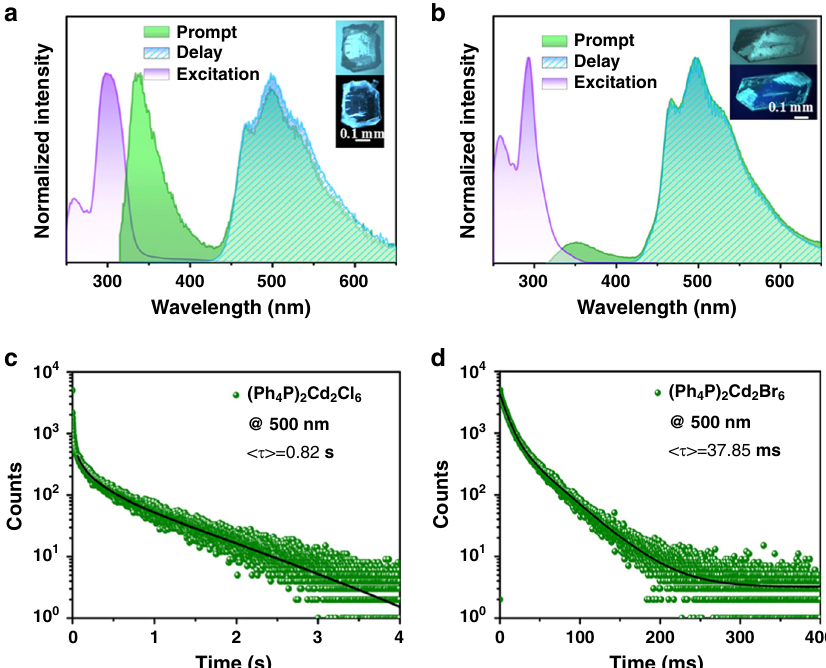
Fig. 2 Luminescence performance of (Ph 4 P) 2 Cd 2 X 6 . Excited, prompt, and delayed PL spectra of a (Ph 4 P) 2 Cd 2 Cl 6 and b (Ph 4 P) 2 Cd 2 Br 6 (the delay time t d is set to 0.1 ms). Inset pictures are photos of crystals with and without excitation. Time-resolved PL decay curve of c (Ph 4 P) 2 Cd 2 Cl 6 and d (Ph 4 P) 2 Cd 2 Br 6 ( λ ex = 300